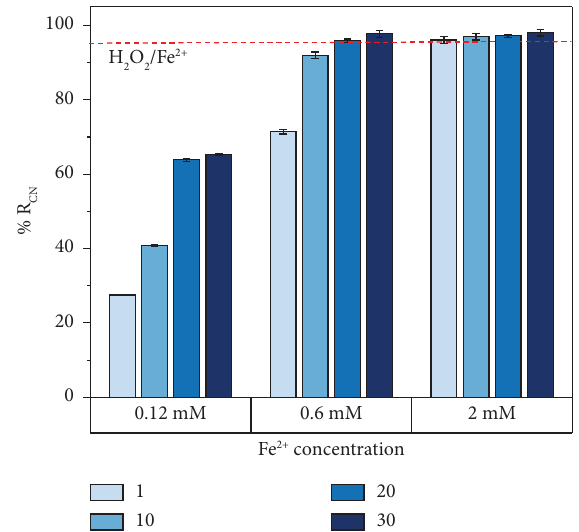
2+ molar ratio on the percentage of 2 O 2 /Fe